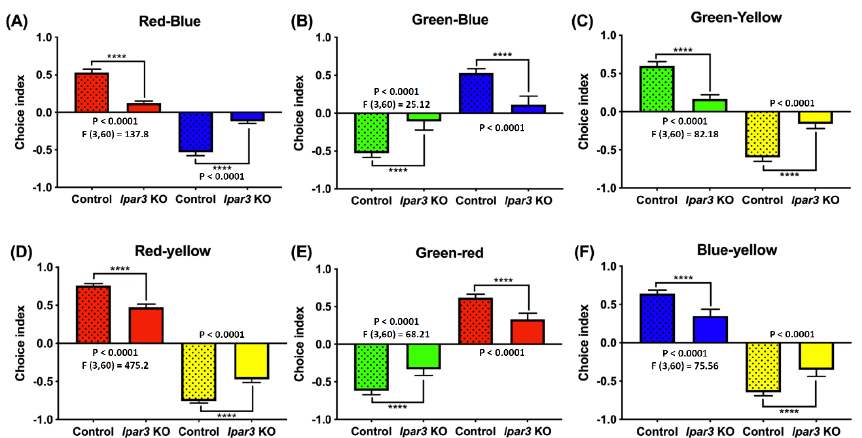
Figure 6. Comparison of color preferences between wild-type and lpar3 KO zebrafish. The color preference results obtained from ( A ) red and blue combination, ( B ) green and blue combination, ( C ) green and yellow combination, ( D ) red and yellow combination, ( E ) green and red combination, and ( F ) blue and yellow combination. The data are presented with means ± standard error of the mean (SEM) and analyzed by one-way ANOVA, followed by Tukey multiple comparison analysis with ( n = 24; ns = non-significant; * p < 0.05; ** p < 0.01; *** p < 0.001; **** p < 0.0001).